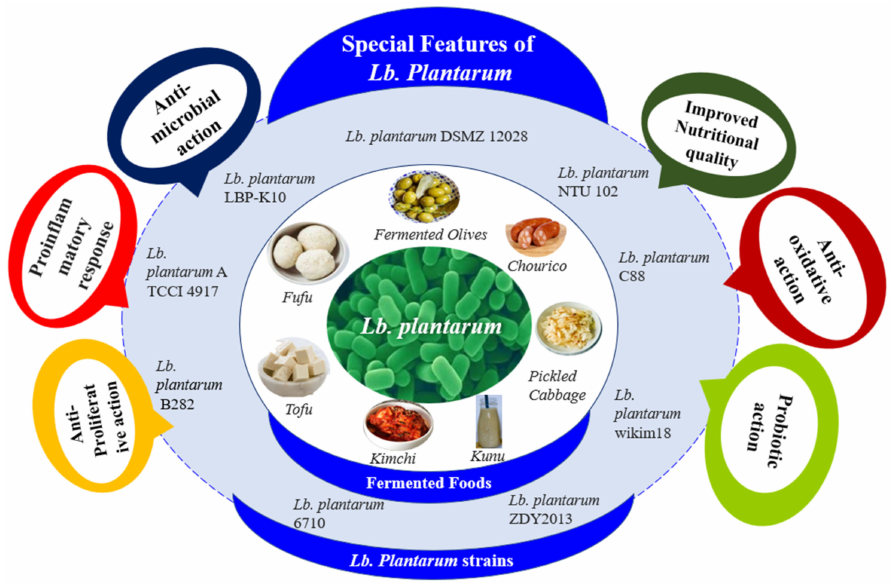
Figure 1. The functionality of Lb. plantarum